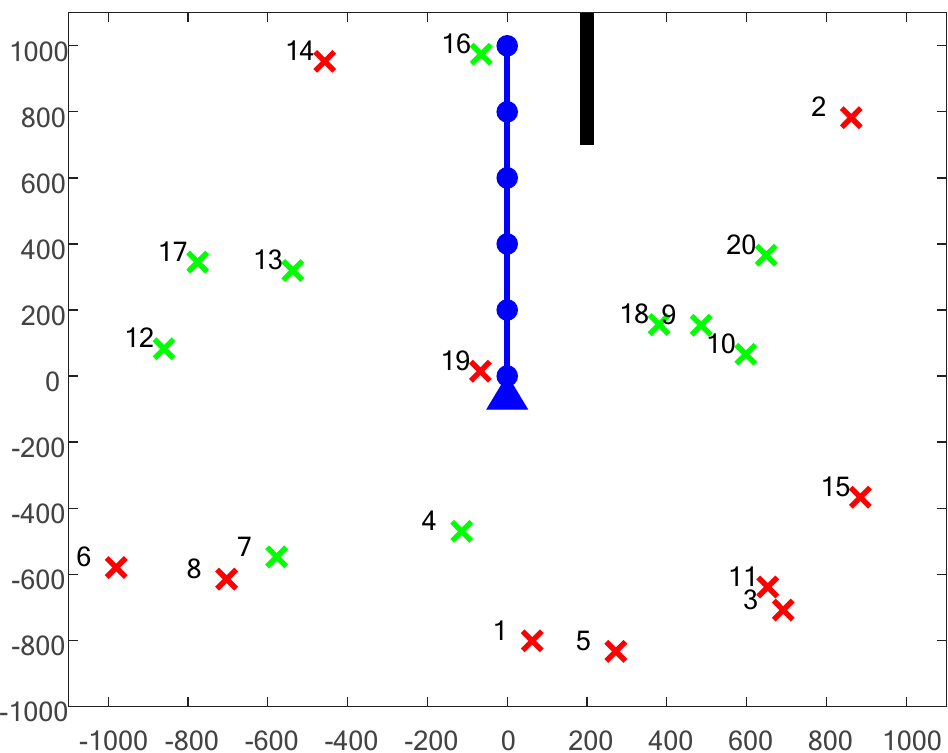
Figure 8. Last link vs. any link simulation. The algorithm indicated that the targets in red were out of reach. The targets in green were within the workspace boundary and were carried on to the path planning stage.